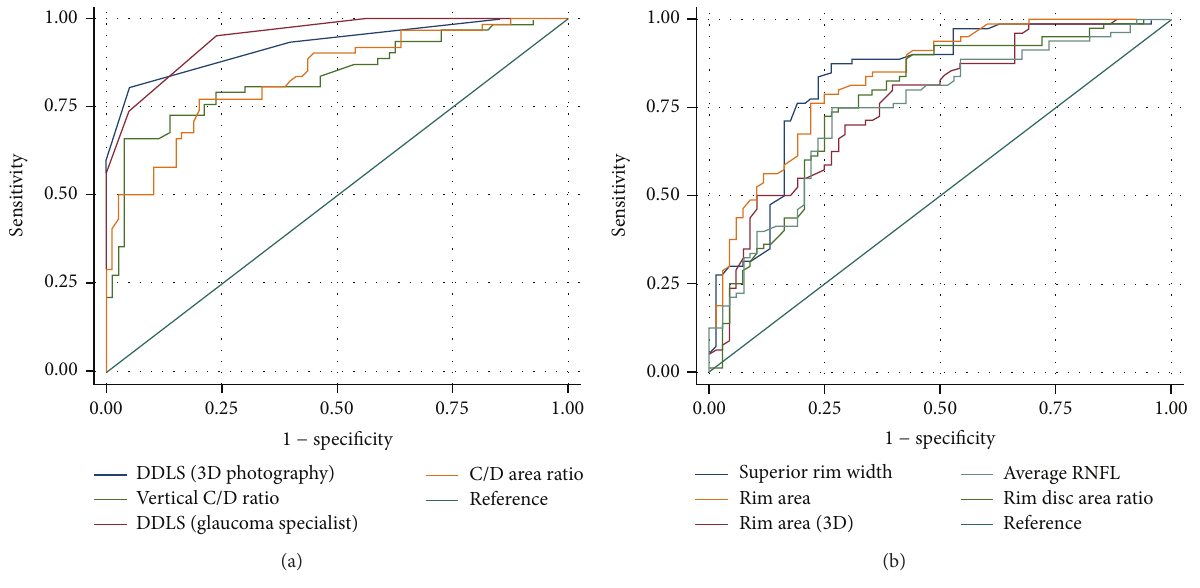
Figure 2: Receiver operating characteristic (ROC) curves for the discriminant functions showing the comparison of the glaucoma and normal groups. (a) The comparison of the disc damage likelihood scale (DDLS; obtained by 3D optic disc photography and the glaucoma specialist), vertical cup-to-disc (C/D) ratio, C/D area ratio, and superior rim width. (b) Comparison of the rim area (obtained by 3D optic disc photography and optical coherence tomography), superior rim width, rim disc area ratio, and average retinal nerve fiber layer (RNFL) thickness. As these parameters were negatively correlated with DDLS, the polarity of the classifiers output was swapped